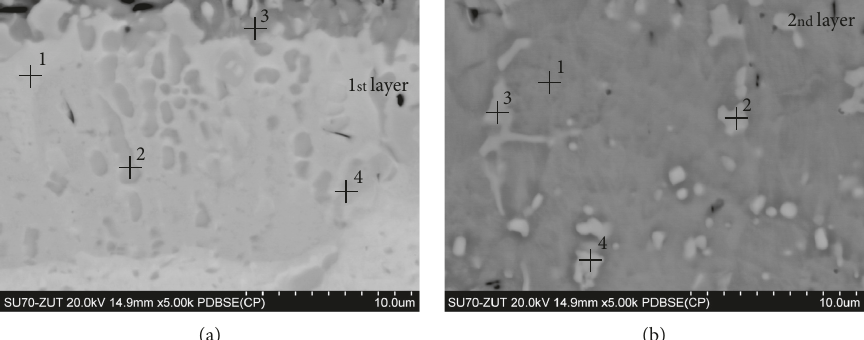
Figure 6: Microstructure (BEI) of (a) the first layer and (b) the second layer of the coating no. 4 obtained at temperature 1000 ° C in 10h (Al/Si � 6) with points of EDS X-ray microanalysis. Table 2: Chemical composition according to Figures 6(a) and 6(b). Chemical composition (%at.), according to Figure 6(a) Chemical composition (% at.), according to Figure Element